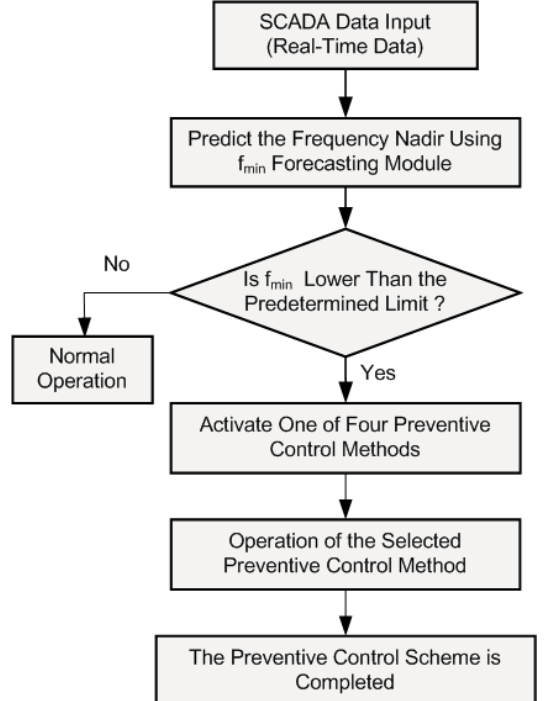
Figure 1. The flowchart of the proposed preventive control strategy including generator rescheduling (GR), battery energy storage system (BESS), direct load control (DLC) and emergency demand response program (EDRP) methods.